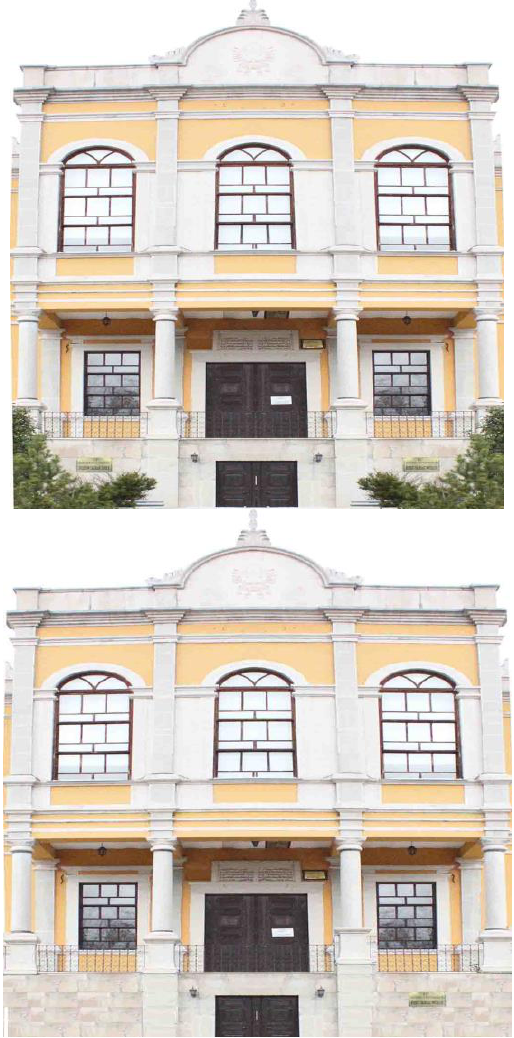
Figure 2. Cleaning the Image with Photoshop Editor